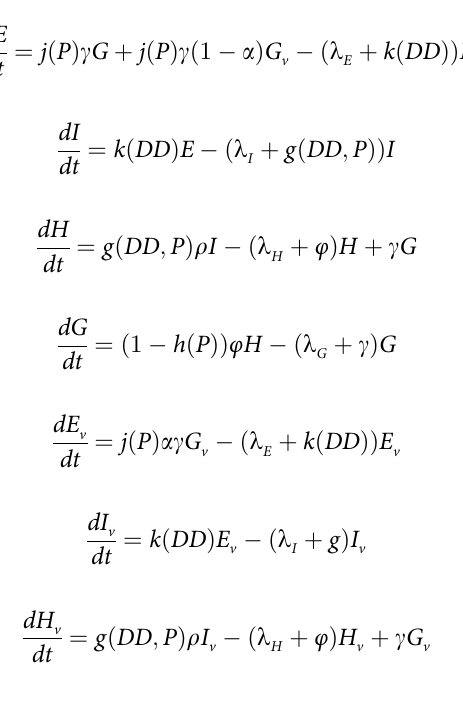
for infected eggs and j γ G + (1 − α ) j γ G for uninfected eggs. LACV is maintained in the zoo- v v notic cycle and venereal transmission is present as well [3]. In both of these transmission types, host-seeking mosquitoes have a chance of becoming infected through feeding on an infected host or venereal transmission, and thus we suppose that the rate of host-seeking mos- quitoes becoming infected gravid is hH . The rate is denoted by h ( P ) H due to the effect of accu- mulated precipitation [26, 41]). The structure of h ( P ) and the value of α will be found through parameter estimation using our data. Our model with transmission is below, and the corre- sponding diagram, Fig 2.